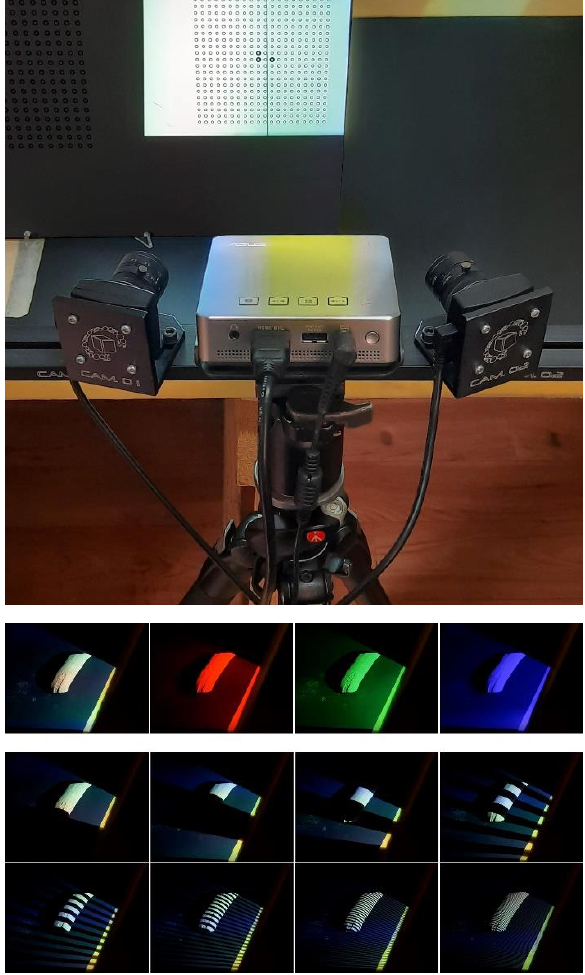
Figure 6 : SCAN in a BOX, calibration of the instrument and projection of the light pattern on the stamp